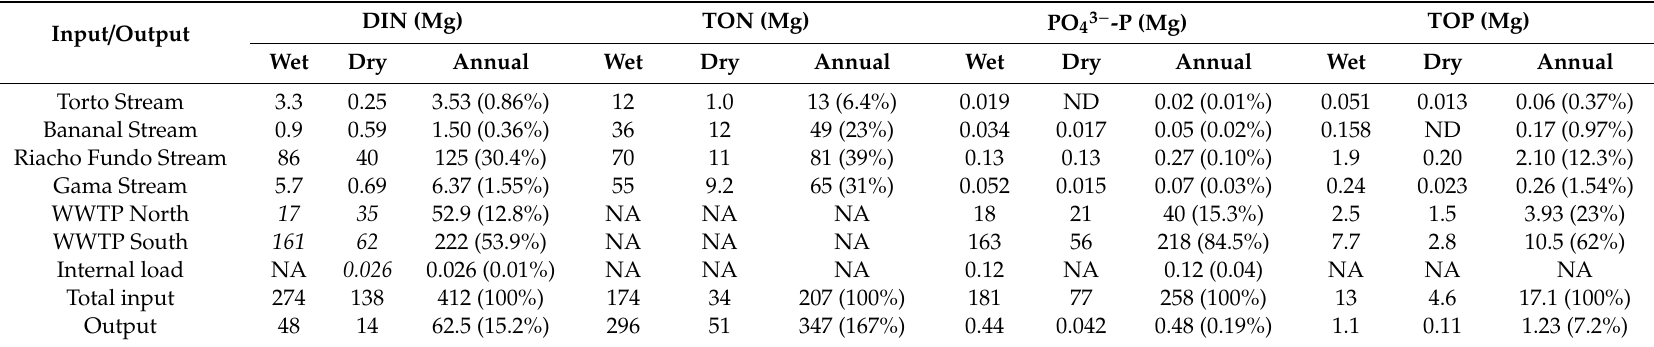
Table 2. Nitrogen and phosphorus load imported from streams (input), WWTPs (input), internal load (input) and discharged through the dam